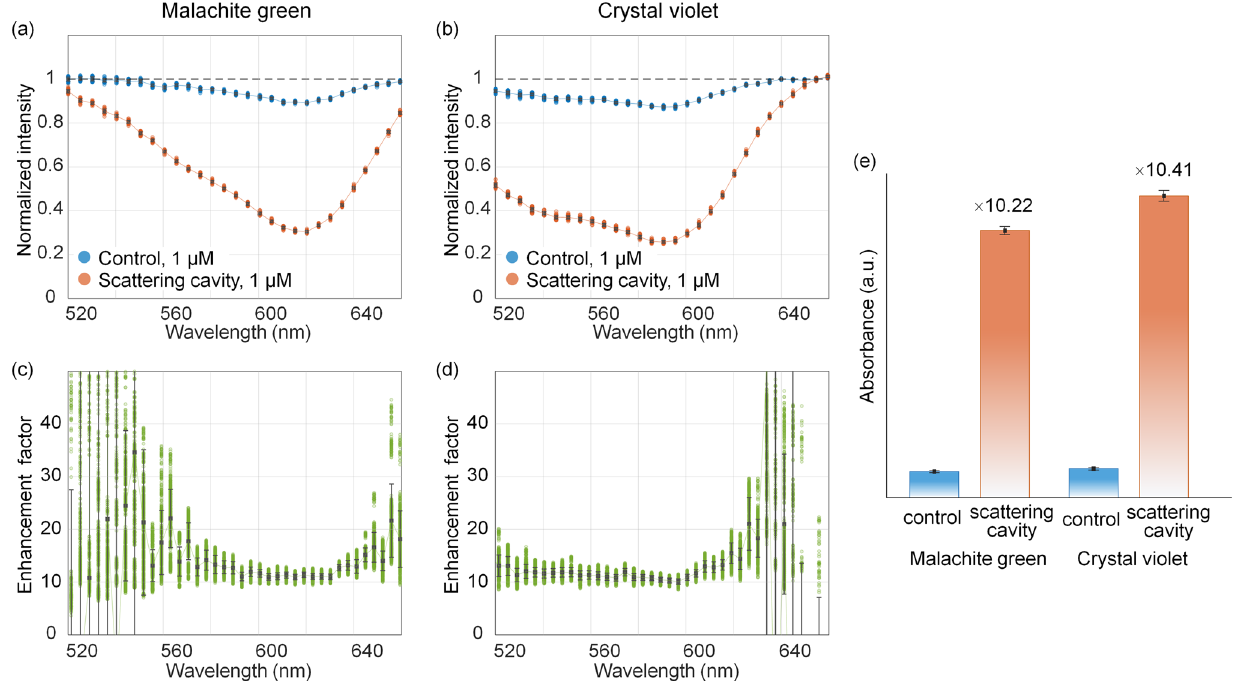
Figure 4. Normalized intensity depending on the wavelength at the concentration of 1 µM for ( a ) malachite green and ( b ) crystal violet aqueous solutions using a conventional method and the scattering cavity. At each wavelength, 25 measurements were performed. The enhancement factors as a function of the wavelength for ( c ) malachite green and ( d ) crystal violet aqueous solutions. ( e ) The averaged enhancement factors near a dip of the normalized intensity for malachite green and crystal violet aqueous solutions. Error bars, standard